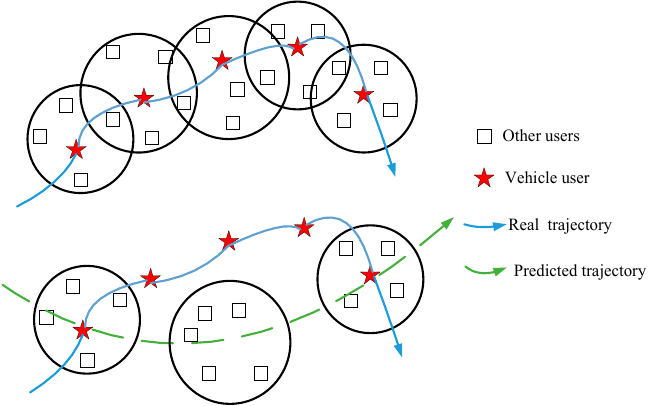
Figure 6. Resisting location correlation attack (LCA).